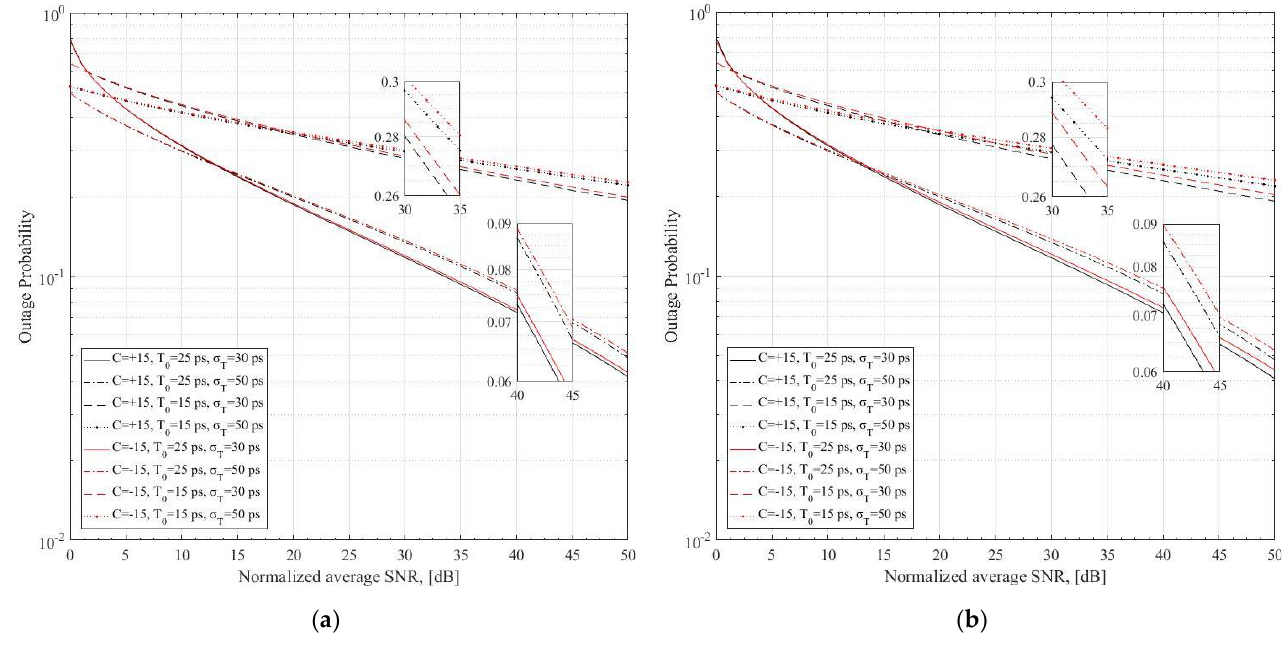
Figure 2. Outage probability as a function of the normalized average SNR with various original pulsewidths, TJ strength parameters, and opposite chirp values for an FSO link of ( a ) z = 5 km and ( b ) z = 10 km.